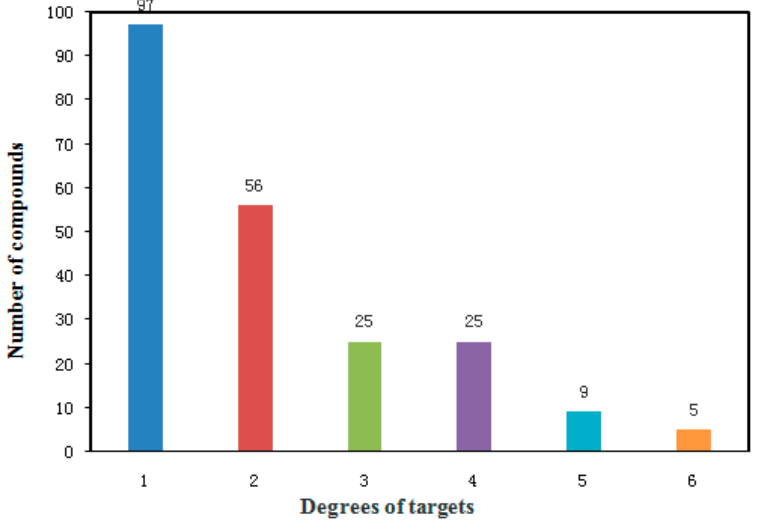
Figure 3. Degree distribution between compounds and targets.